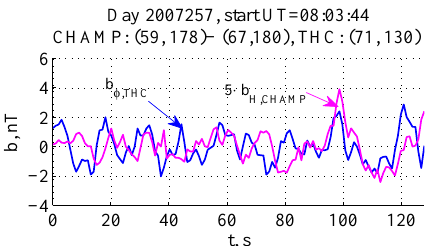
Figure 4. Filtered magnetograms for THEMIS-C ( b ϕ ) and CHAMP ( b D ) components for the 128s interval starting at 08:03:44UT on day 2007257. Average latitude and longitude values in CGM coor- dinates of the northern magnetic field line footprint of THEMIS-C’s location during the interval shown are given in the figure